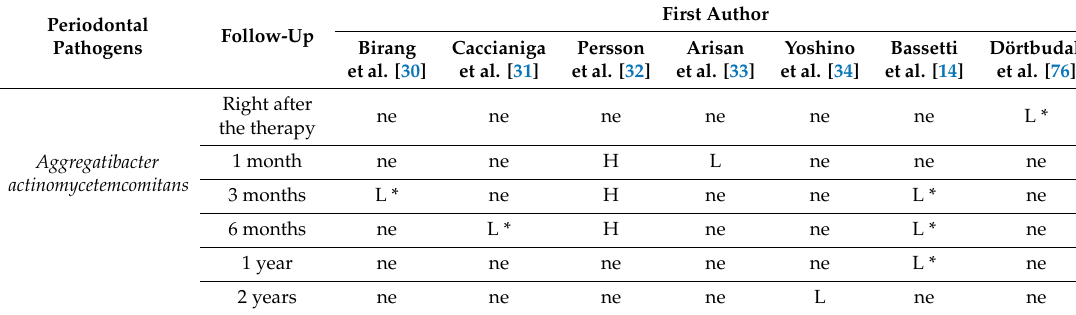
Table 6. Results of individual